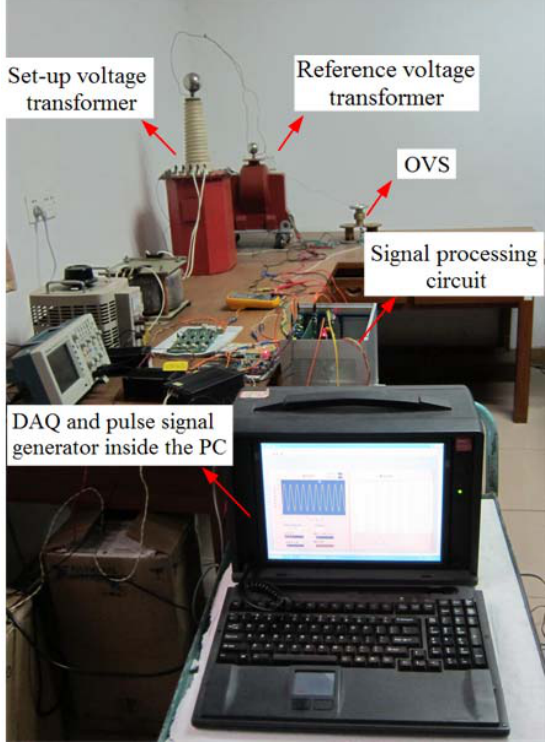
Figure 4. Experimental setup of the